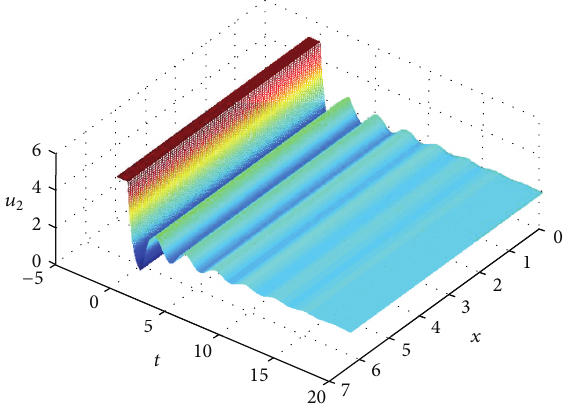
Figure 3: State response 𝑢2(𝑡, 𝑥) of model (44) without impulsive effects.